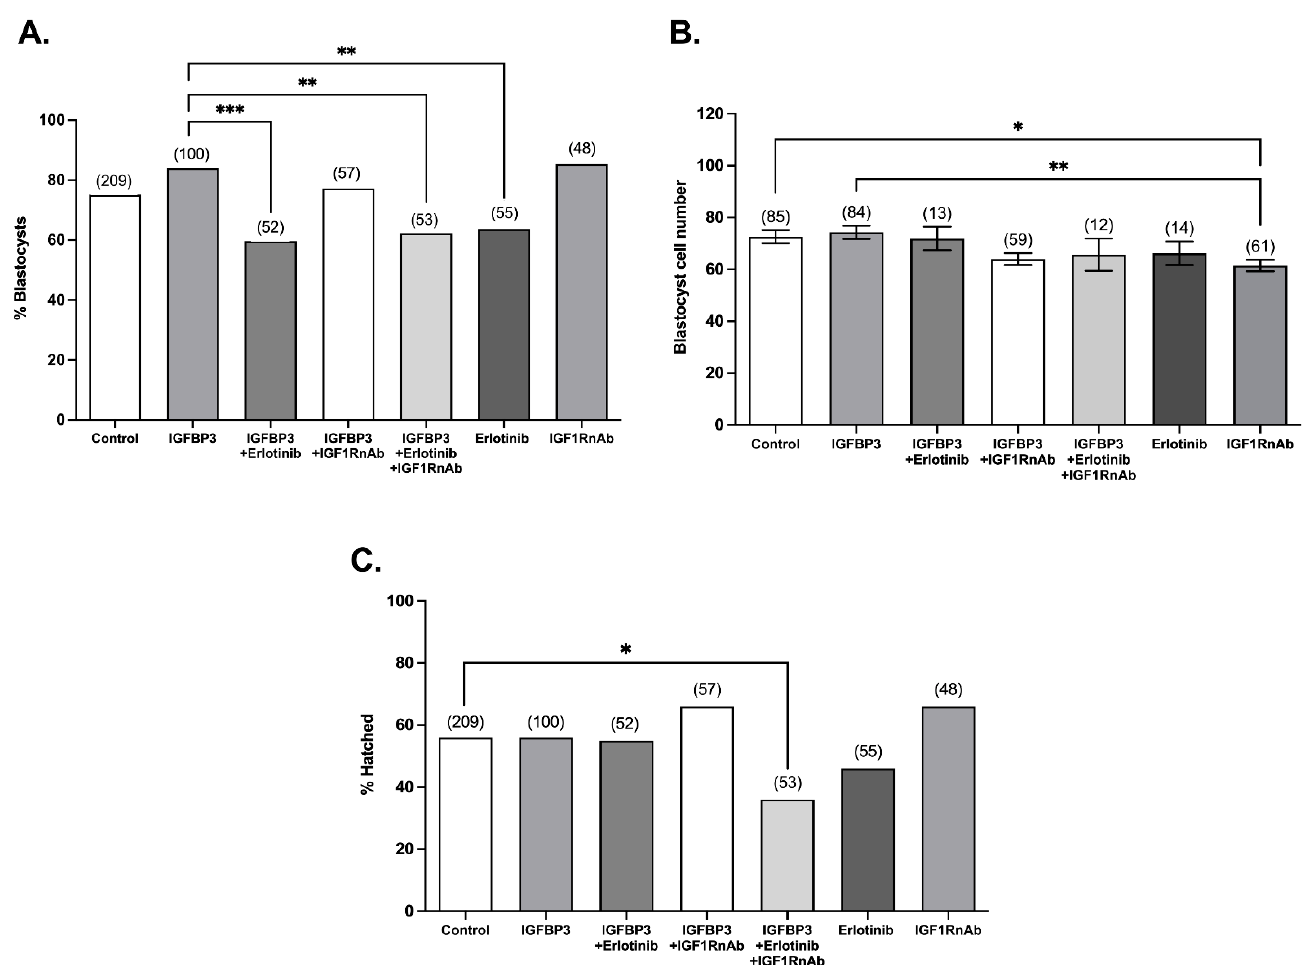
Figure 4. EGFR inhibition decreases the percentage of embryos that reach the blastocyst stage. Mouse zygotes were isolated and cultured at a density of 1 embryo/100 µ L in medium alone (control) or medium containing 100 ng/mL IGFBP3, 100 ng/mL IGFBP3 plus 2 µ M Erlotinib, 100 ng/mL IGFBP3 plus 2 mg/mL IGF1RnAb, 100 ng/mL IGFBP3 plus 2 µ M Erlotinib plus 2 mg/mL IGF1RnAb, 2 µ M Erlotinib, or 2 mg/mL IGF1RnAb. On day 6 of culture, the percentage of embryos that developed to the blastocyst stage ( A ) was recorded, and blastocysts were fixed and stained with DAPI to count the number of cells within each blastocyst ( B ). The percentage of blastocysts that hatched from the zona pellucida ( C ) was also recorded. The percentage of embryos that reach the blastocyst and hatched blastocyst stages between treatments were compared using a chi-squared test. The average cell number between treatments was compared using one-way ANOVA with Tukey’s post hoc test. Data shown represent 6–9 independent experiments (number of embryos are in parentheses). * p < 0.05, ** p < 0.01, *** p < 0.001.